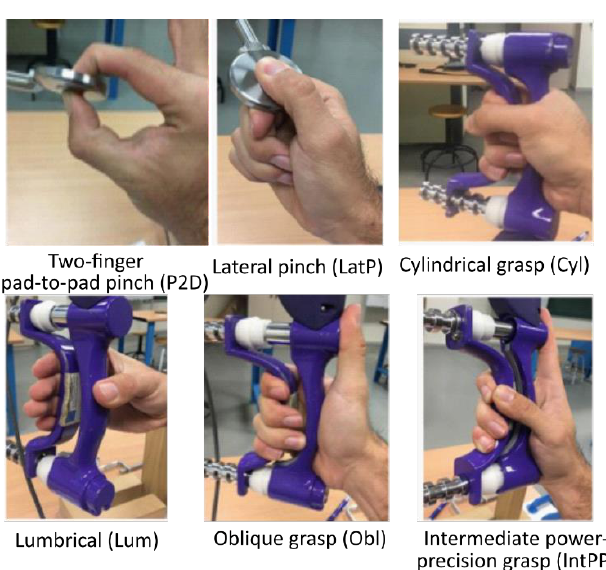
Figure 1. Six grasp types whose maximum grasping effort (MGE) was recorded. Grasp type defini- tions according to [30].